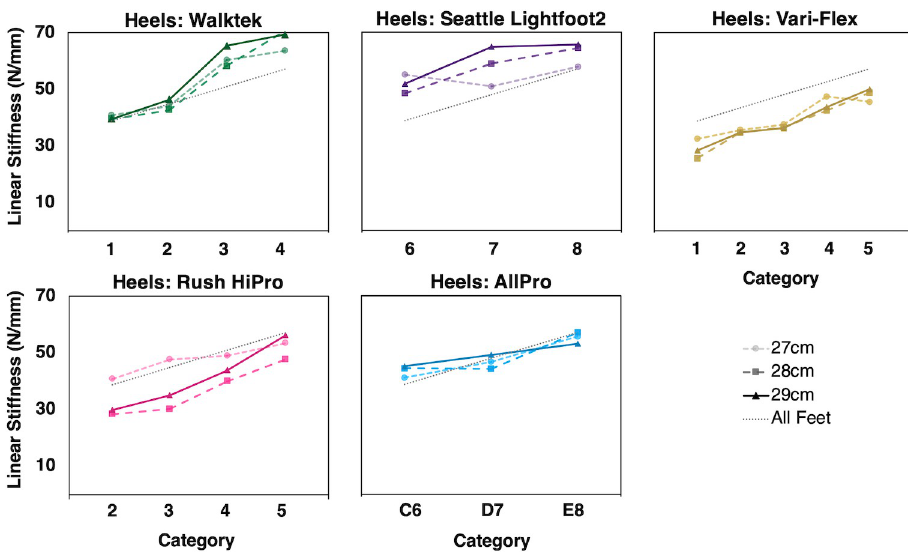
Fig 4. Calculated linear stiffness of prosthetic heels by scaled stiffness category (min 1, max 5). Five types of commercial prosthetic feet with three different foot sizes (i.e., 27-29cm) tested for each stiffness category (for a total of 15 groups, where group is defined by all feet of the same type and size). Dashed lines indicate the regression slope averaged across all foot types and sizes from linear mixed effects regression of calculated stiffness on stiffness category and size, with random effects for foot type and foot type by stiffness category interaction. Calculated linear stiffness was significantly associated with scaled stiffness category ( p = 0.001), although depending on the type of foot, variability in stiffness across foot sizes and across consecutive stiffness categories is observed ( p < 0.01). On average, heel stiffness values were greater than forefoot stiffness values, across all foot types, which may be attributed to the shorter lever arm of the heel compared to that of the